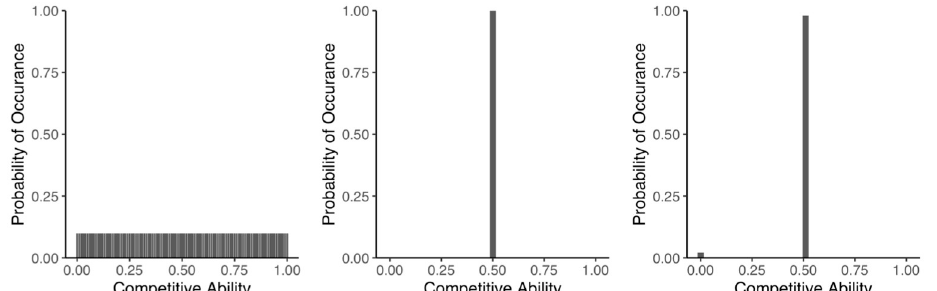
Fig 3. Examples of strategies. The strategies are represented by probability distributions that correspond to the distribution of competitive abilities (e.g. traits). A uniform distribution has all values between zero and 1 equally likely. An invariant or degenerate distribution is the opposite; all competitive abilities are equal to the mean lacking any variability. Lake Wobegon is characterized by one zero (loser) and all others have a mean slightly above 0.5, depending on population size. Our results show that the maximally variability, uniform distribution, is an equilibrium strategy that promotes co-existence.